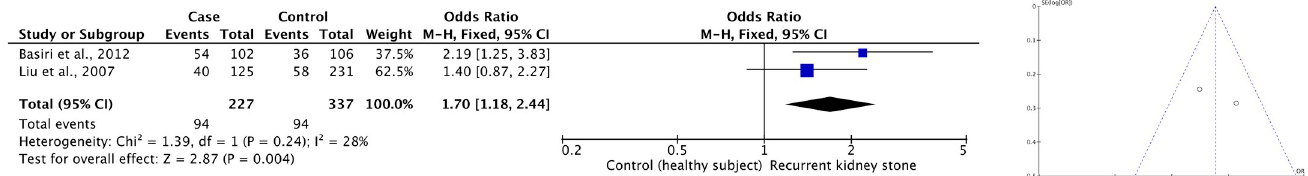
Fig 4. Forest and funnel plots of the VDR FokI polymorphism (recessive model) with healthy subject groups as controls.